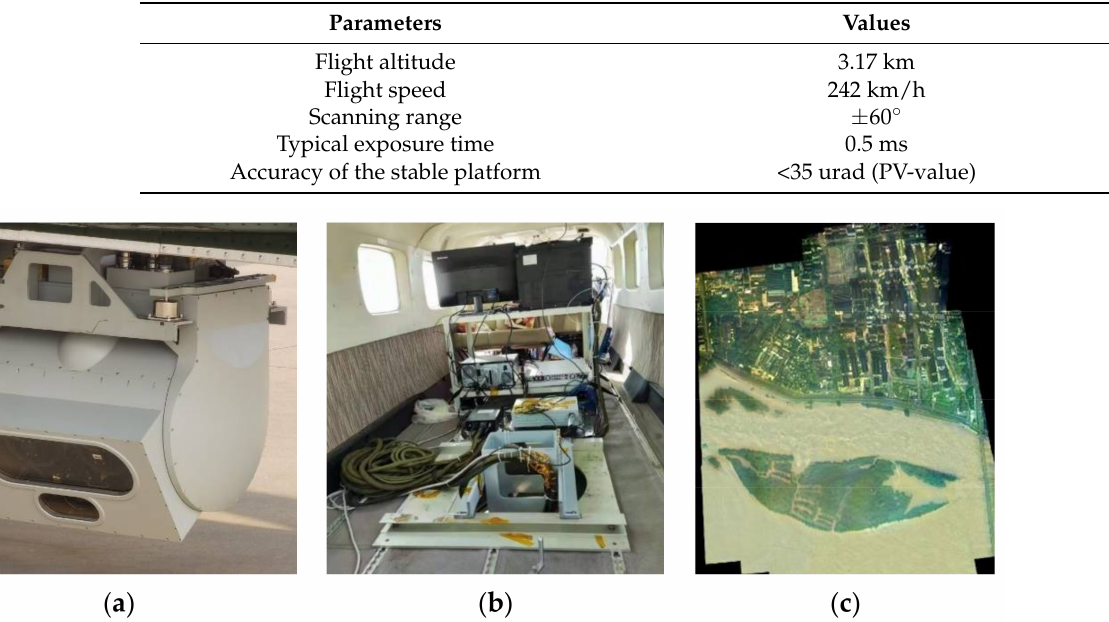
Figure 14. The images of the flight experiment: ( a,b ) the real scene; ( c ) the mapping